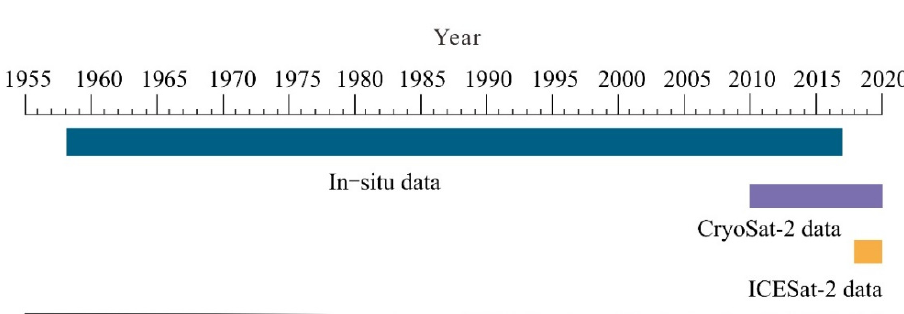
Figure 2. The lake level data over the different periods used in this study.